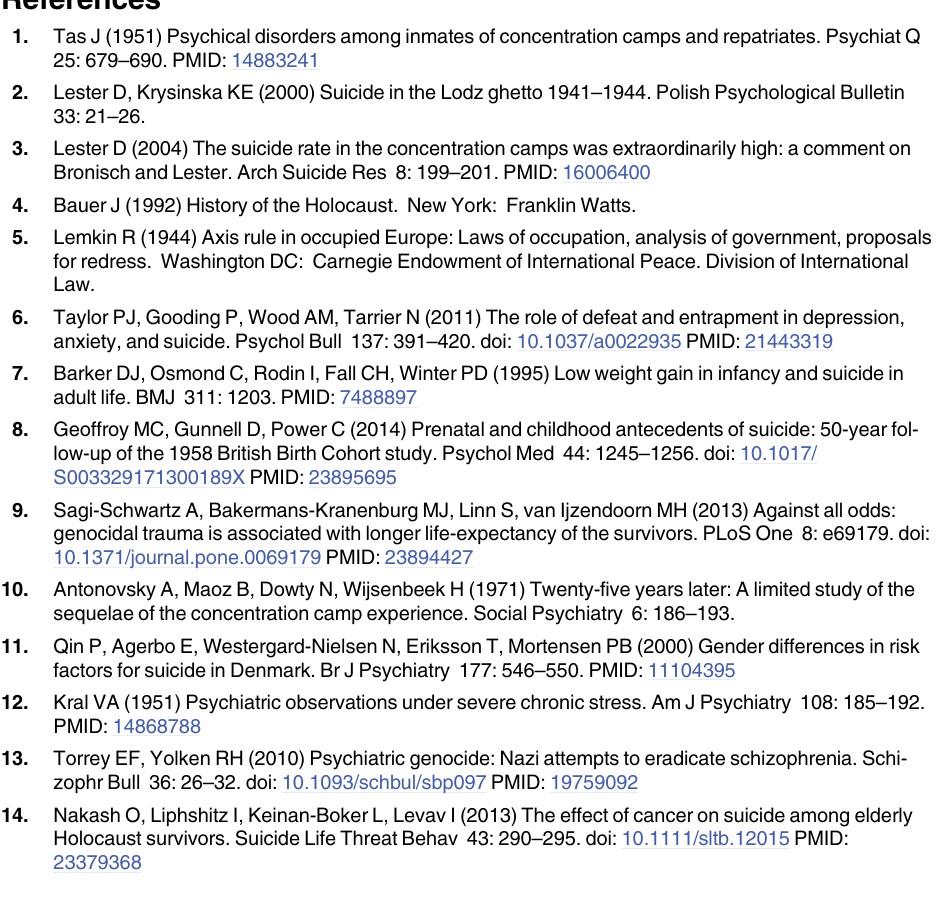
S1 Table. Cox regression model terms of the sex by likely exposure group interactions. Note. Female sex and indirect exposure were reference